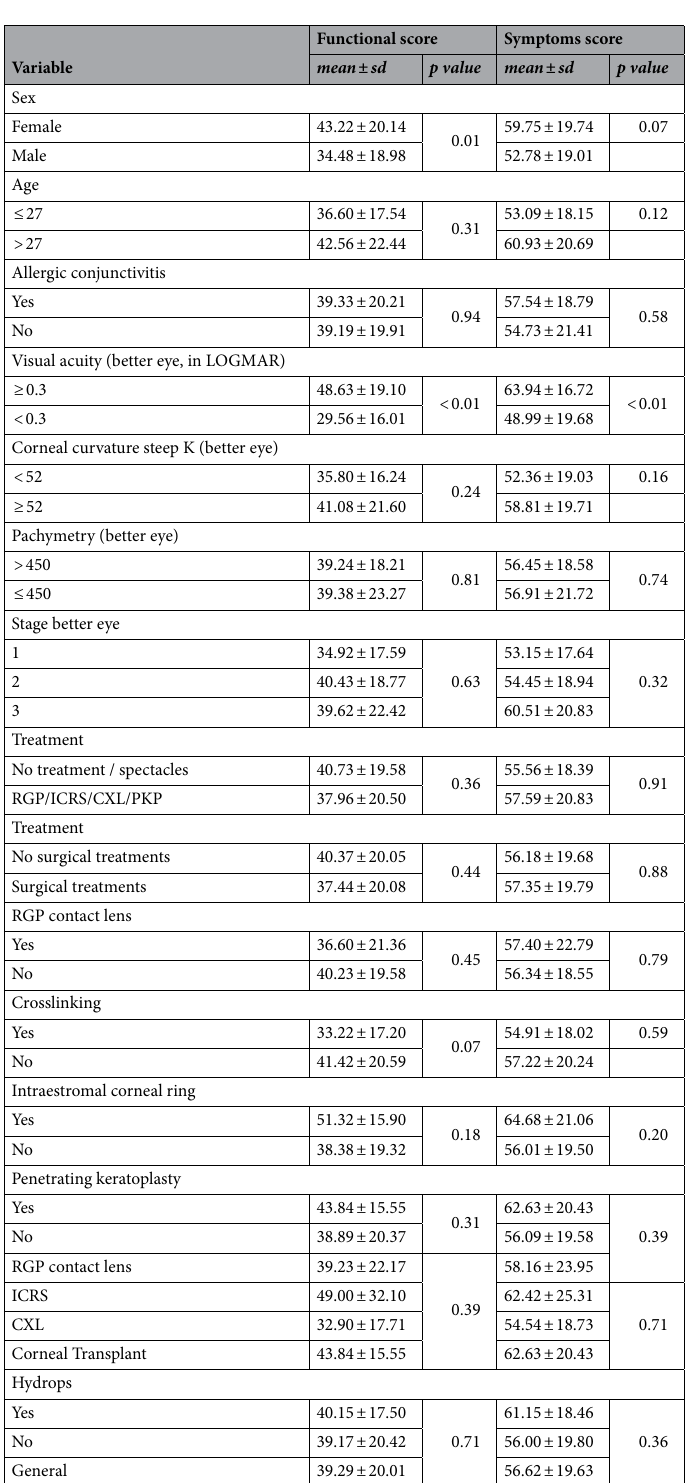
Table 5. Univariate analysis on the association between clinical and demographic factors and Functional and Symptoms scores on the KORQ Questionnaire. CXL corneal collagen cross-linking; RGP rigid permeable